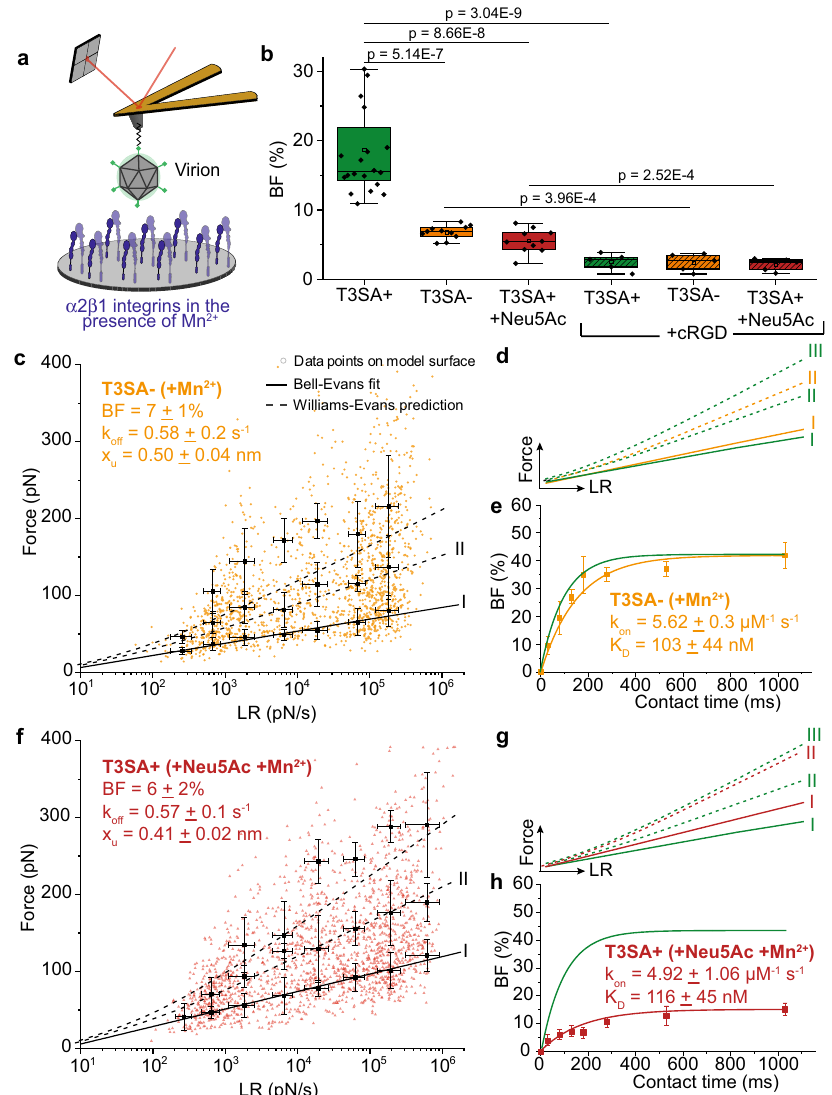
Fig. 4 Binding of the reovirus σ 1 attachment protein to sialic acid alters β 1 integrin interaction. The effect of a point mutation in the SA-binding site of σ 1 protein ( c – e ) or addition of exogenous α -SA ( f – h ) on reovirus- α 2 β 1 integrin interactions was determined using model surfaces. a Schematic depicts the experimental set up. All experiments were conducted in the presence of Mn 2 + . b Box plot shows BF between T3SA + or T3SA- virions and integrins quanti fi ed using AFM under the conditions shown. The horizontal line within the box indicates the median, boundaries of the box indicate the 25th and 75th percentile, and whiskers indicate the highest and lowest values. An open square within each box indicates the mean. c DFS plot shows interaction forces between T3SA- and integrins. d Comparison of forces required to rupture bonds between integrins and T3SA + (green) or T3SA- (yellow). e BF plotted as a function of contact time shows comparable k on and K D values for T3SA + (green) and T3SA- (yellow) interactions with integrins. f – h DFS plot ( f ) and kinetic on-rate measurements ( h ) show differences in T3SA + interactions with β 1 integrins in the presence (red) and absence (green) of α -SA (1 mM Neu5Ac) ( g ). Error bars indicate s.d. of the mean. All data are representative of N = 5 independent experiments. P values were determined by two- sample t -test using Origin.